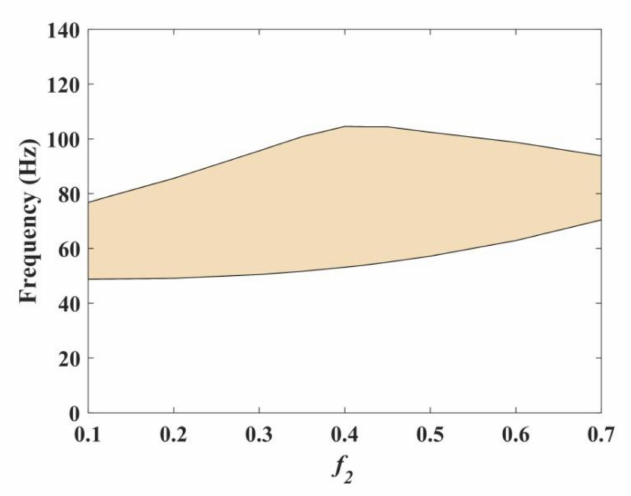
Figure 7. The influence of f 2 on the band